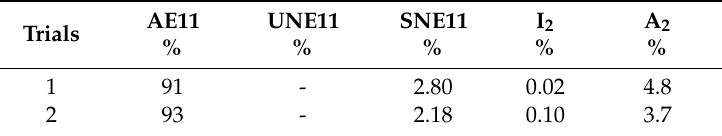
Influence of the solvent on the conversion of UNE11 to AE11. H 2 pressure: